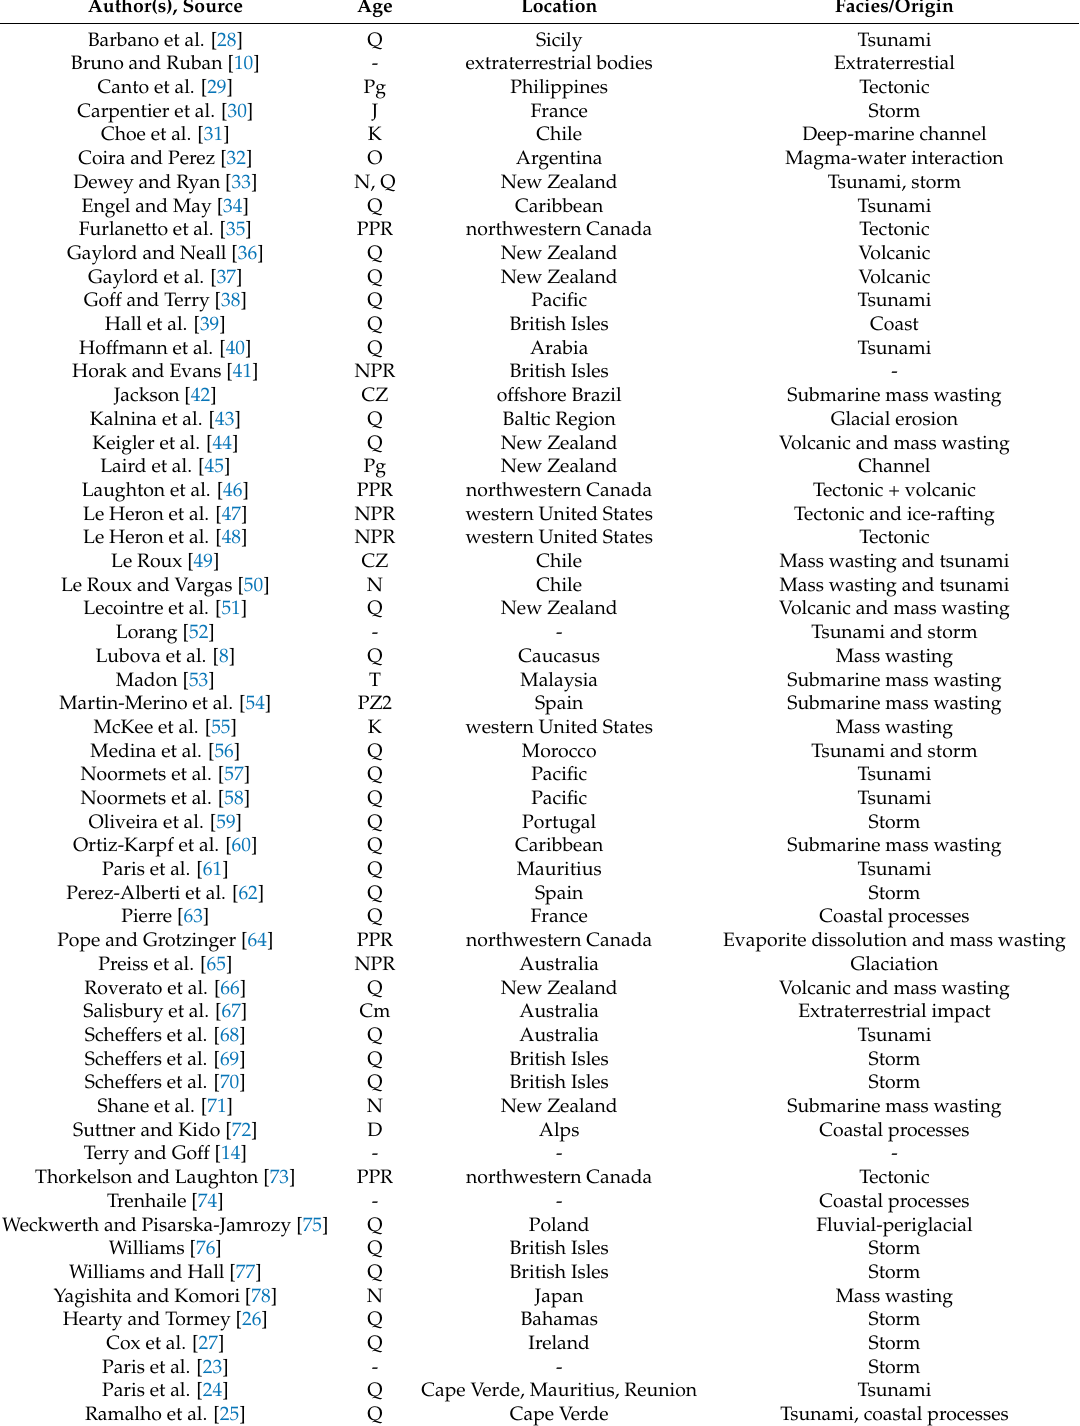
Table 1. Megaclast-related literature sources for the purposes of examination of the term